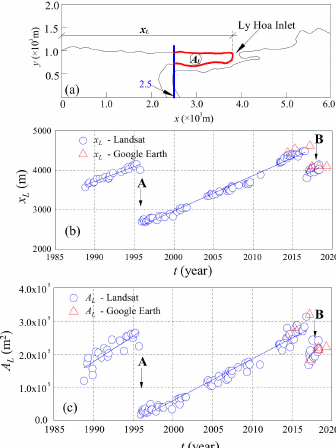
Figure 8. ( a ) Definition sketch of the left sand spit of Ly Hoa Inlet, ( b ) Time variations of the tip coordinate ( x L ), ( c ) Time variations of the sand spit area ( A L ).